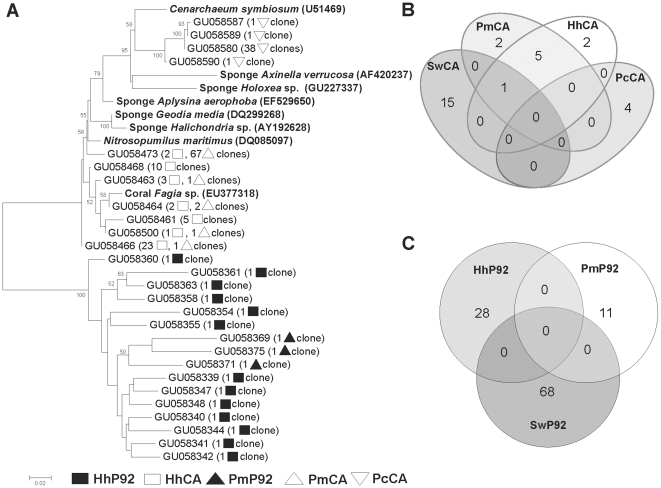
Sponge Crenarchaeota communities.(A) Neighbour-joining 16S rRNA phylogenetic tree. Sponge archaeal clones (▪) HhP92, (□) HhCA, (▴) PmP92, (Δ) PmCA and (◊) PcCA Venn diagram with OTUs grouped at 97% similarity in (B) Archaea related to seawater and sponges from the Cagarras Archipelago and (C) Archaea related to seawater and sponges from P92. Hh, Hymeniacidon heliophila; Pm, Paraleucilla magna; Pc, Petromica citrina; CA, Cagarras Archipelago; P92, inner bay site.